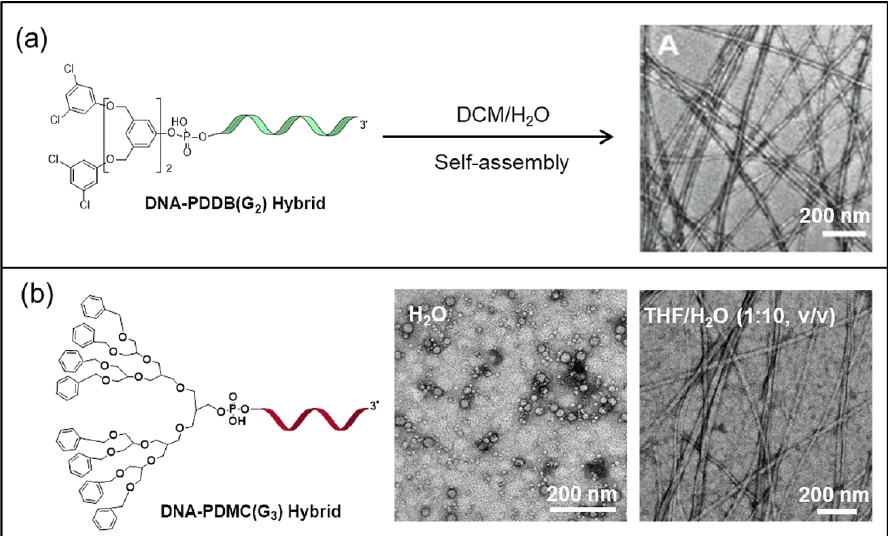
Figure 8. Self-assembly of amphiphilic DNA – Dendron hybrids. ( a ) Nanofibers from DNA and the second generation (G 2 ) of dendron PDDB (poly(benzyl ether) dendron peripherally modified with dichlorobenzene) hybrids in dichloromethane and water mixture solution. The green segment indicates DNA strand. ( b ) Spherical micelles and nanofibers from DNA and the third generation (G 3 ) of dendron – PDMC hybrids in water and THF/H 2 O (1:10, v / v ), respectively. The red color of strand indicates DNA. Reproduced with permission from the authors of a previous papers [76,78].